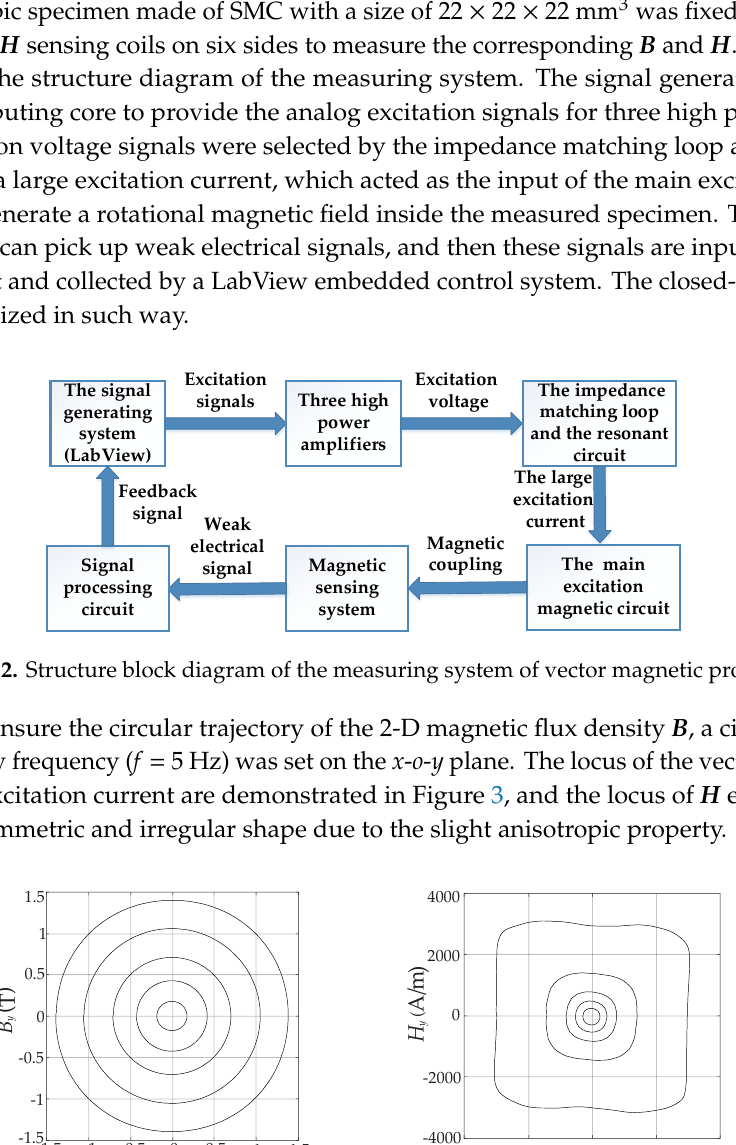
Figure 1. Experimental platform: ( a ) Main measuring system; ( b ) Diagrammatic sketch of magnetic circuit for measurement. The measuring system was used to get the 2-D magnetic properties of the material. During the experiment, a cubic specimen made of SMC with a size of 22 × 22 × 22 mm 3 was fixed in a sensing box mounted with B - H sensing coils on six sides to measure the corresponding B and H .